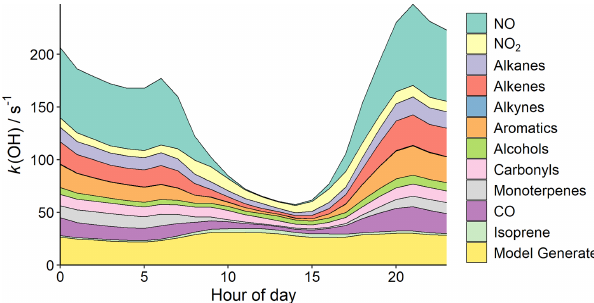
Figure 7. Diel profile of campaign-averaged VOCs, CO, and NO x contributions to OH reactivity, k